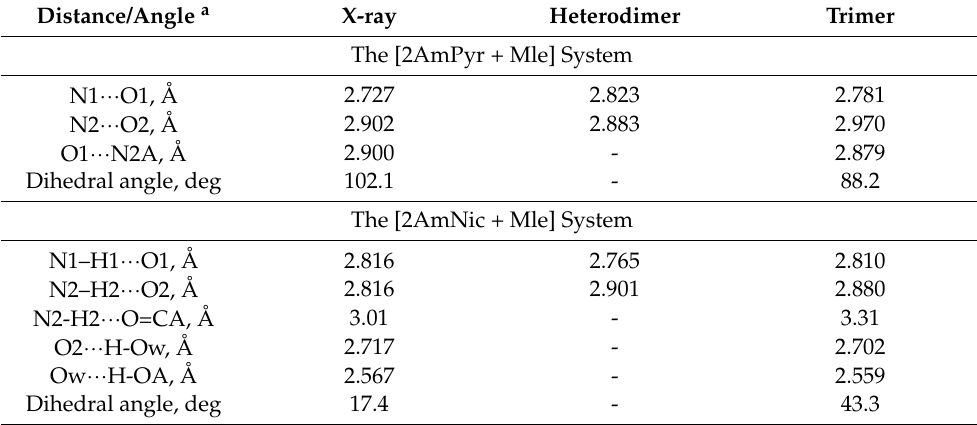
Table 1. The N ··· O/O ··· O distances of intermolecular H-bonds in crystal fragments vs. the corre- sponding distances in heterodimers and trimers, computed using B3LYP/6-31G** in the PCM model